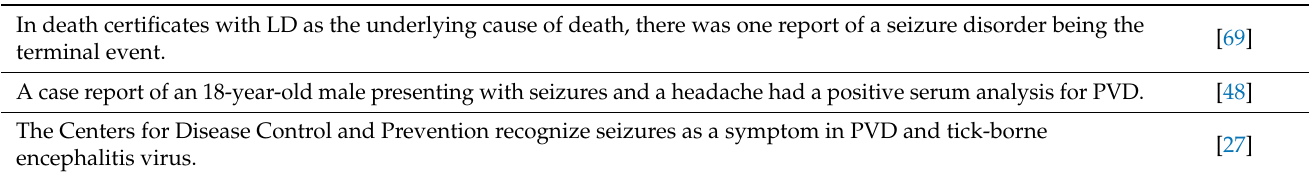
Table 5. Vertigo and/or dizziness may not be fully recognized as a TBD symptom. Medical literature